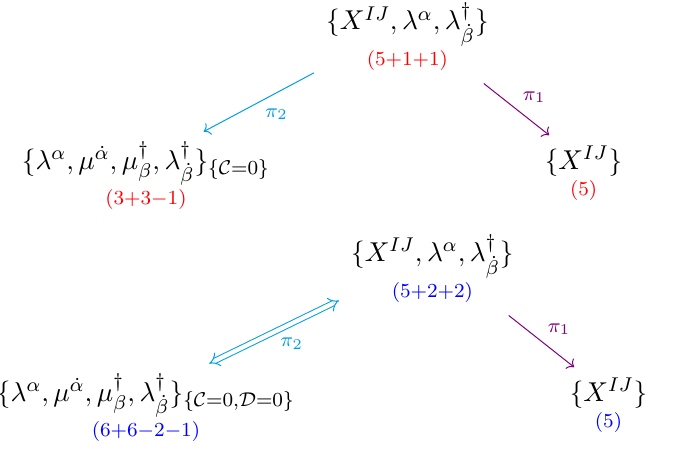
Figure 4 . (Left) Double fibration of the projective spinor bundle { x ˙ α twistor space { µ ˙ α , λ β } ∼ = CP 3 and the space-time on the boundary of AdS 5 , { x ˙ α in red are the complex dimensions of the corresponding spaces. (Right) The same fibration after imposing the euclidean reality conditions. Numbers in blue now show the real dimensions of the corresponding spaces. Note that π 2 is an isomorphism in this signature.